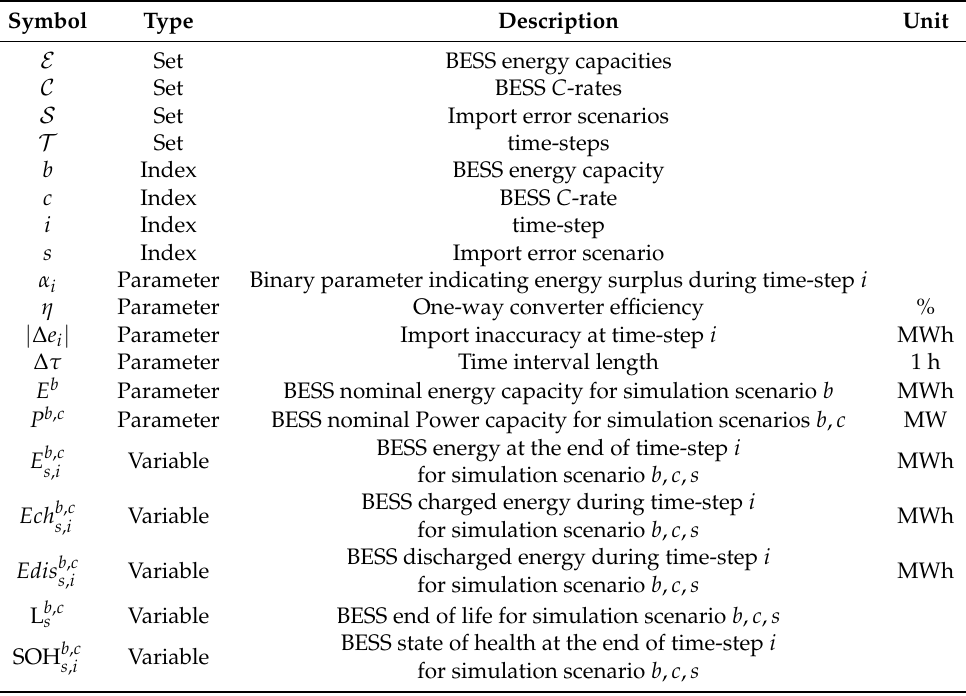
Table 4. Proposed method